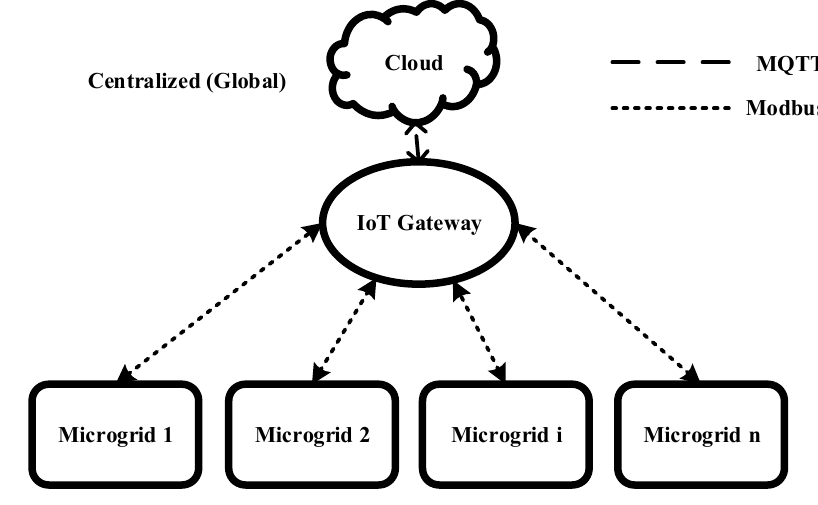
Figure 7. Centralized communication mode.